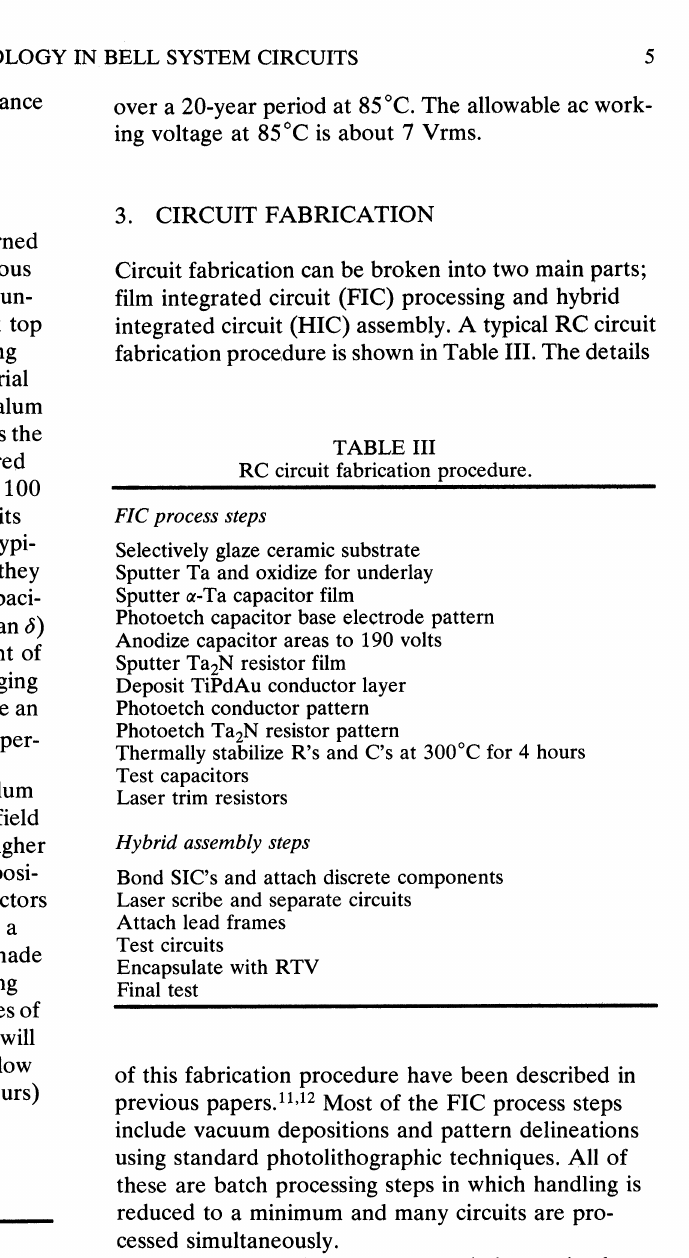
TABLE II Thin film capacitor